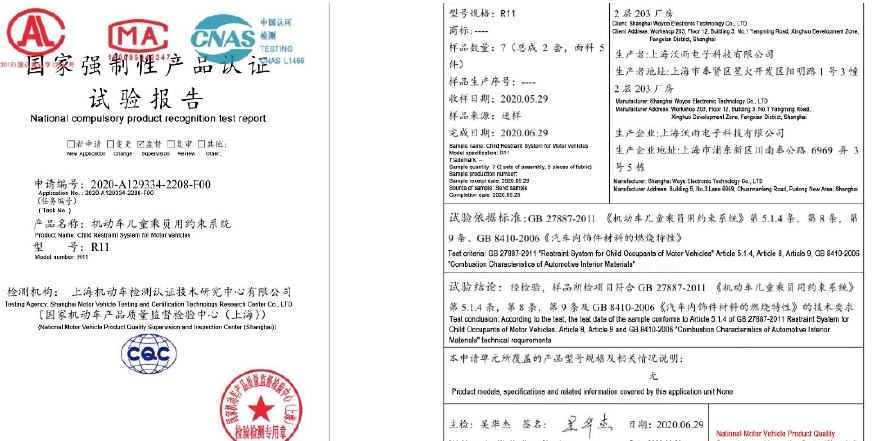
Figure A1. The intelligent child restraint system studied in this paper has passed China’s national compulsory product certification test (including crash test).